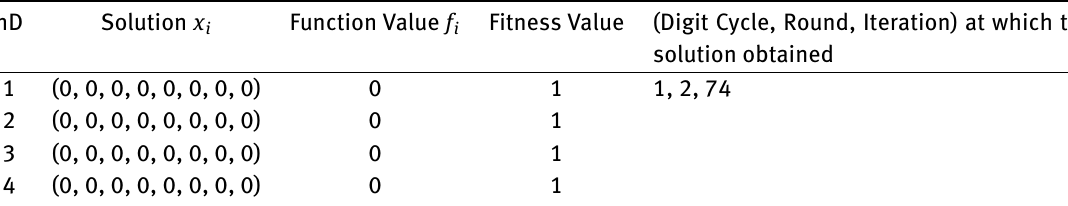
Table 28: Digit Cycle Results for Powel’s function with 8 variables